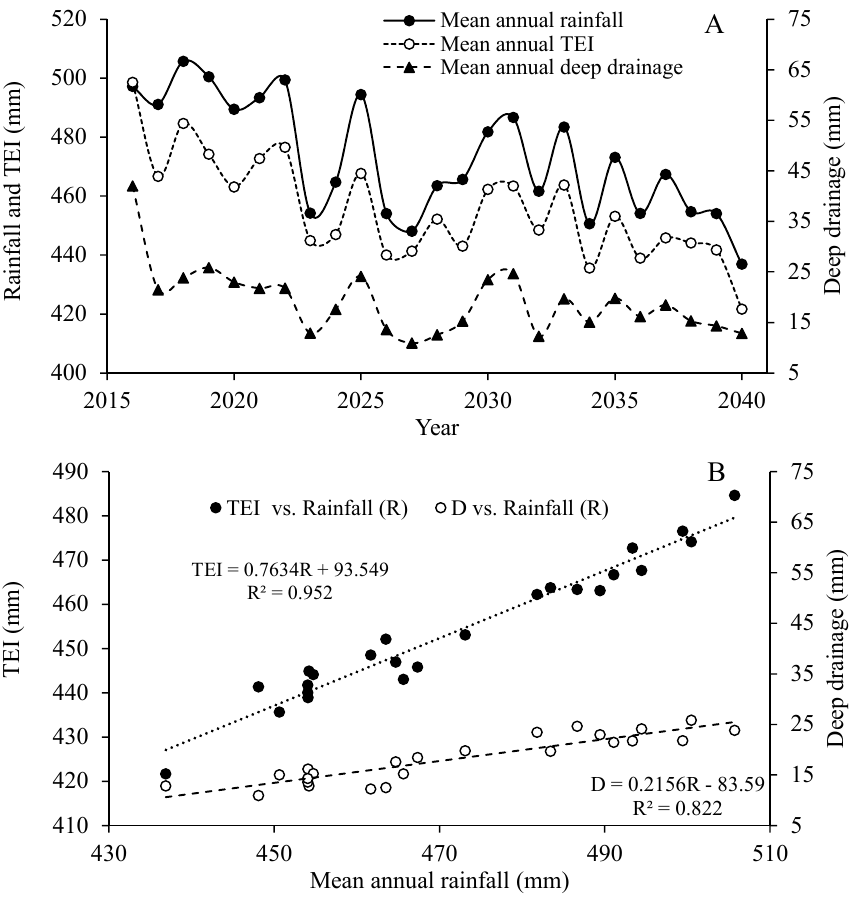
Figure 7. Mean annual actual evapotranspiration (TEI), deep drainage (D) and rainfall (R) over time ( A ) together with relationships between TEI and D with mean annual rainfall ( B ).